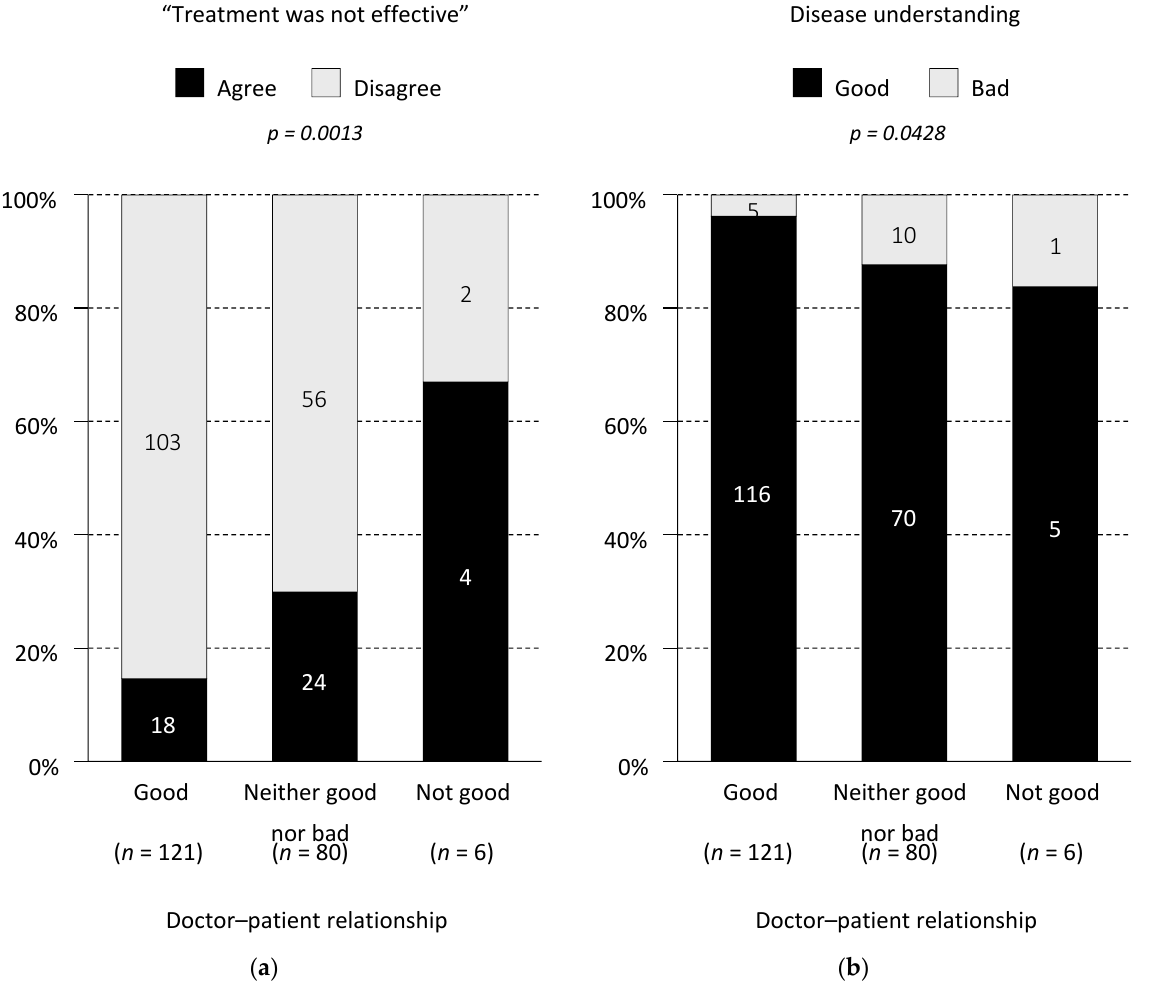
( a ) ( b ) Figure 2. Doctor–patient relationship in Cohort 1. ( a ) Correlation between the doctor–patient relationship (good/neither good nor bad/not good) and perceived treatment efficacy. ( b ) Correlation between the doctor–patient relationship (good/neither good nor bad/not good) and disease understanding. The numbers on the bars indicate the number of respondents. The responses “quite good” and “not quite good” were combined as “good” or “bad”. Table 4. Self-reported visual acuity of the affected eye and agreement with the response “treatment was ineffective”. Self-Reported Visual